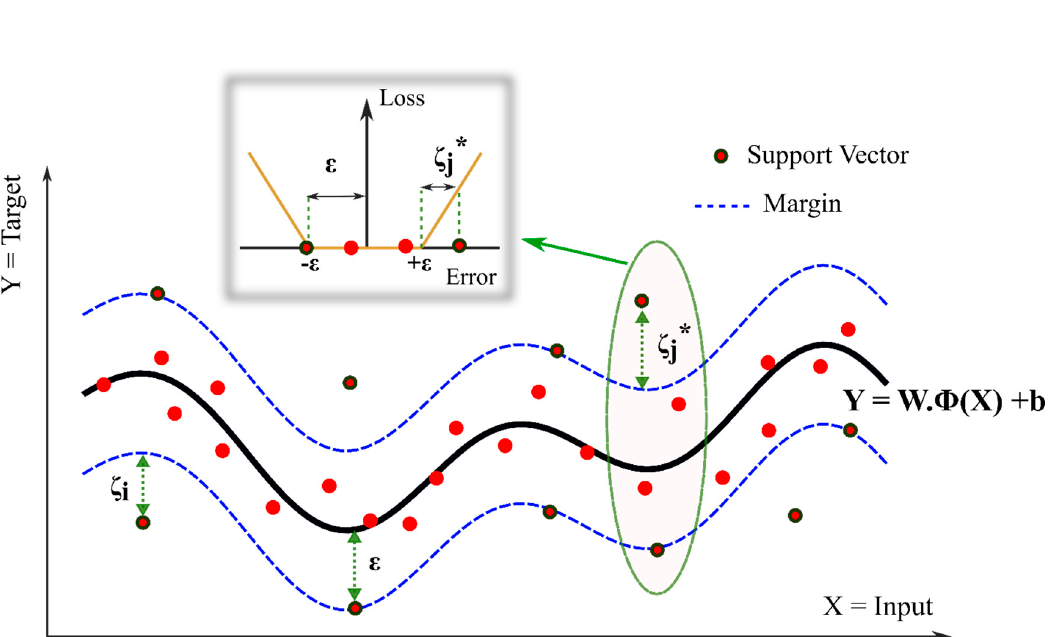
Figure 2. Soft margin nonlinear SVR (support vector machine for regression) with ε -insensitive loss function ( ϕ (.) is a feature mapping function, W is the weight matrix, and b is bias vector).